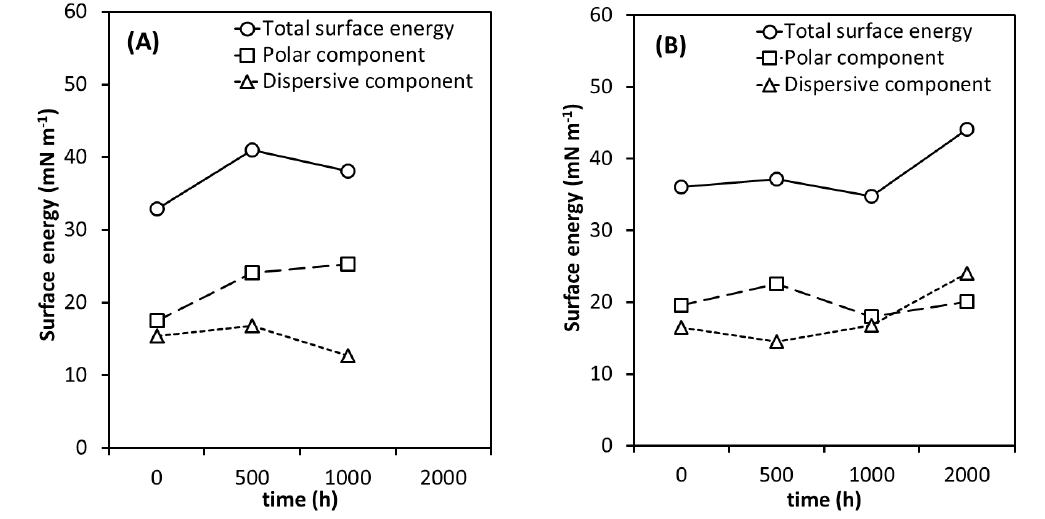
Figure 5. Surface energy of ( A ) the PHBV and ( B ) the PHBV / TiO 2 as a function of increasing weathering exposure time.